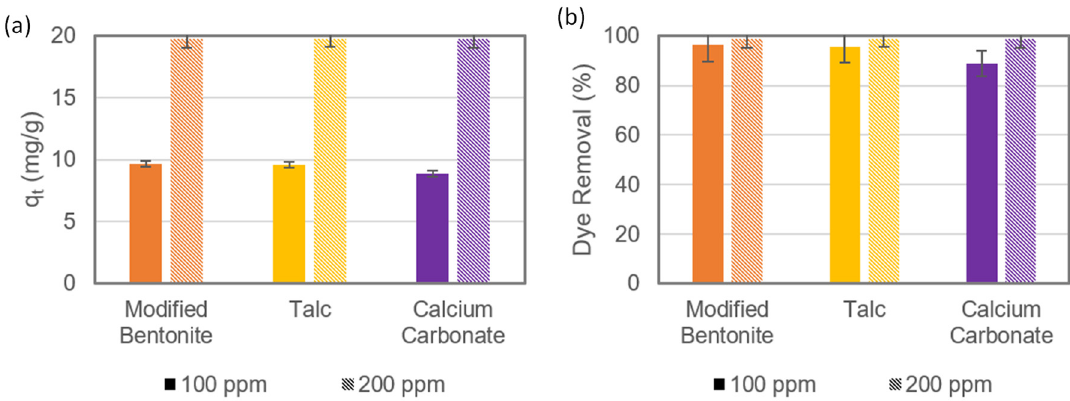
Figure 4. ( a ) Equilibrium adsorption capacity ( q t ) and ( b ) associated percent uptake of dye with non-coagulated modified bentonite, talc and calcium carbonate after 15 min of mixing in a 500 mL conical flask with 100 and 200 ppm dye solutions.